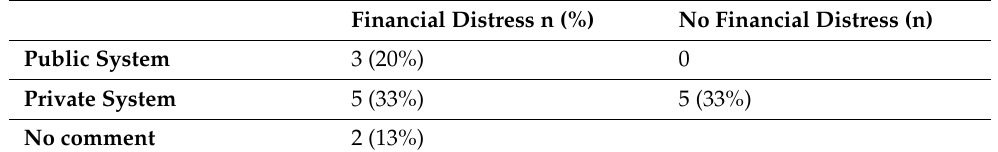
Table 5. Financial Stress and Healthcare